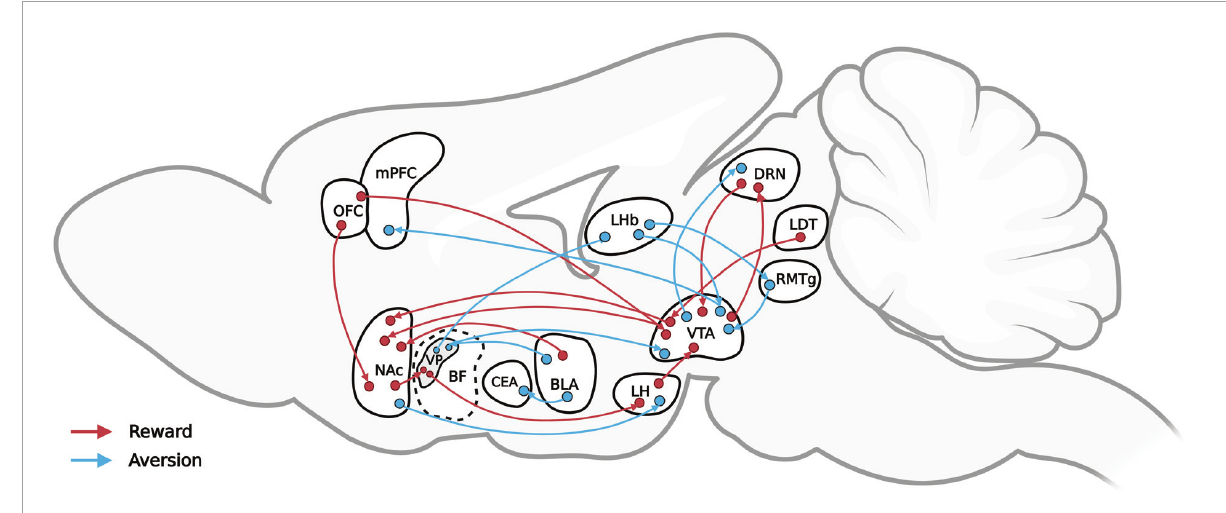
FIGURE1 A simplified representation of the reward-mediating (red) and aversion-mediating (blue) neural pathways that recent optogenetics-based behavioral studies have